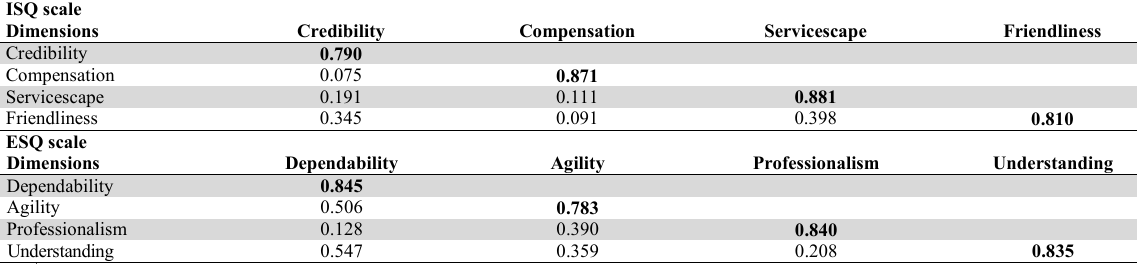
Result of Discriminant Validity for ISQ and ESQ scale ISQ scale